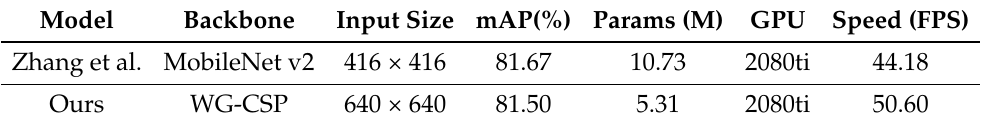
Table 3. The results of the comparison with Zhang et al.